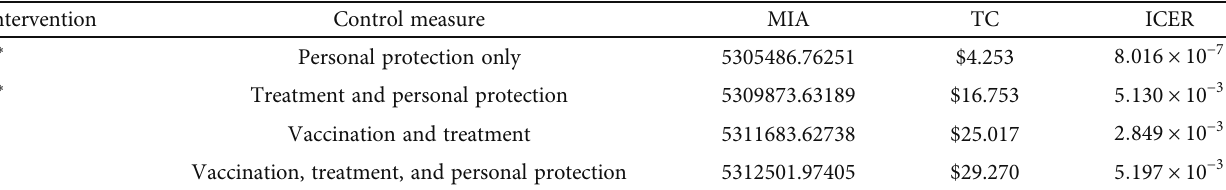
Table 9: Comparing ICER I 3 with I 6 .